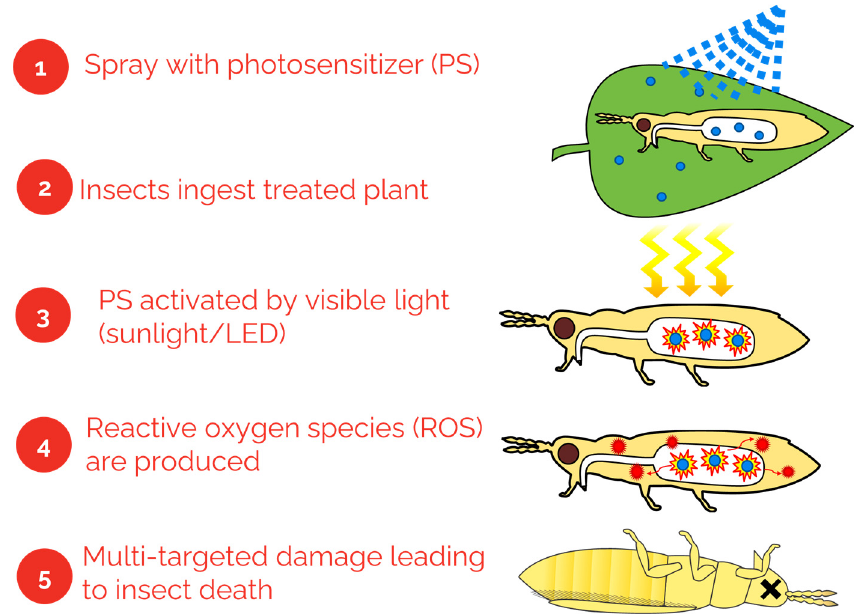
Figure 1. Diagrammatic illustration of mode of action of sodium magnesium chlorophyllin (Chl, E140) photosensitizer, SUN-D-06 PS, on western flower thrips (WFT), Frankliniella occidentalis . Graphic design and copyright: Ashley Summerfield.